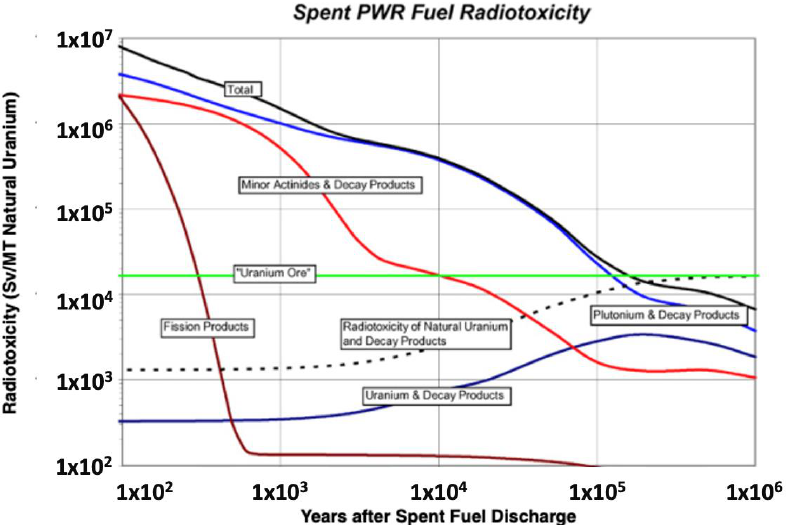
Figure 7. Motivation for transmutation adapted from [40]. Comparison of the radiotoxicity of nuclear waste from uranium-based PWR to that produced by the naturally occurring uranium needed to generate 1 metric ton of enriched uranium. Permission to reuse figure granted from Elsevier.